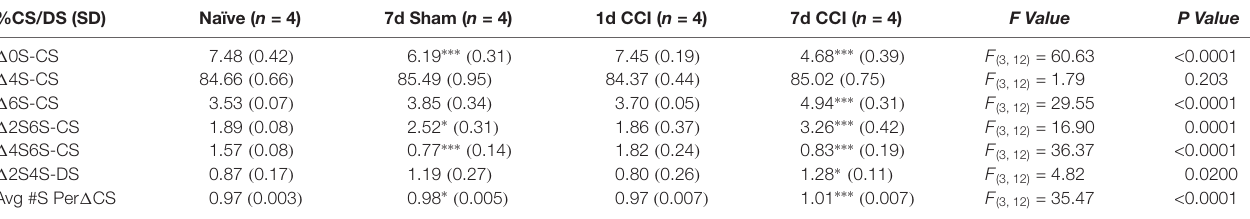
TABLE 1 | Relative percentages of CS isomers in the means of five representative coronal sections spanning the rostro-caudal extent of the injury site ( − 1.0, − 1.5, − 2.0, − 2.5, and − 3.0 mm from Bregma).